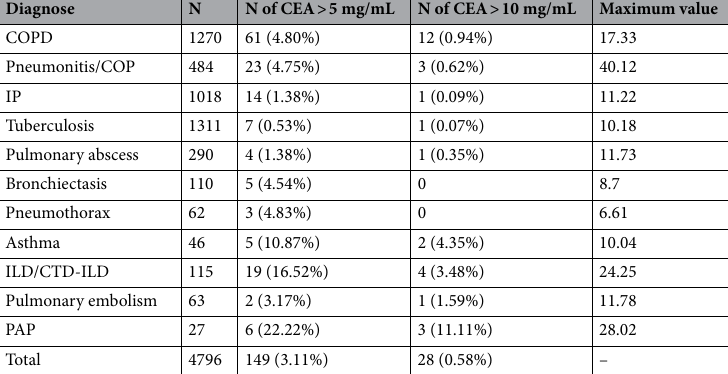
Table 1. Serum CEA contents according types of benign lung diseases. COPD Chronic obstructive pulmonary disease, ILD Interstitial lung disease, CTD-ILD Connective tissue disease-associated interstitial lung disease, PAP Pulmonary alveolar proteinosis, IP Inflammatory pseudotumor, COP cryptogenic organizing